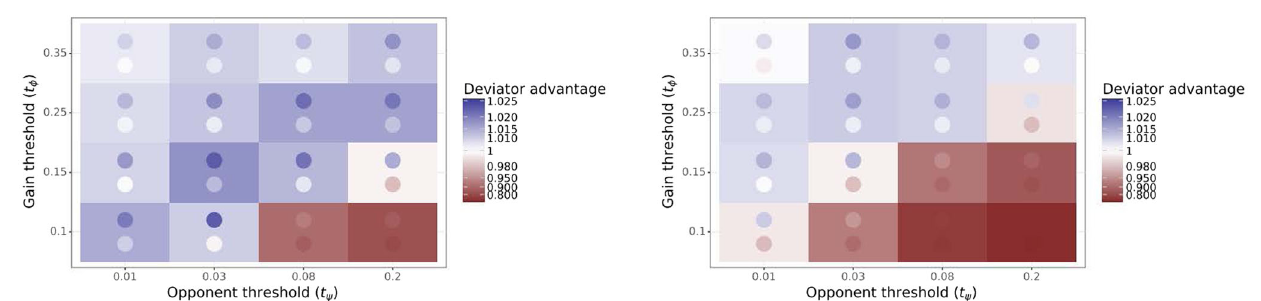
Fig. 8 | Impact of the Learned Deviator parameters ( t ϕ , t ψ ) on the ratio W dev W betweentheDeviator ’ swinrate W dev andtheSanctioningAgent ’ swinrate W san , when playing against a population of 6 Sanctioning agents. We call this the Deviator advantage. The cells are arranged along a horizontal t ψ axis and a vertical t ϕ axis. The color of each cell indicates the Deviator advantage: blue indicates the advantageis>1and,i.e.,theLearnedDeviatoroutperformstheSanctioningAgents,